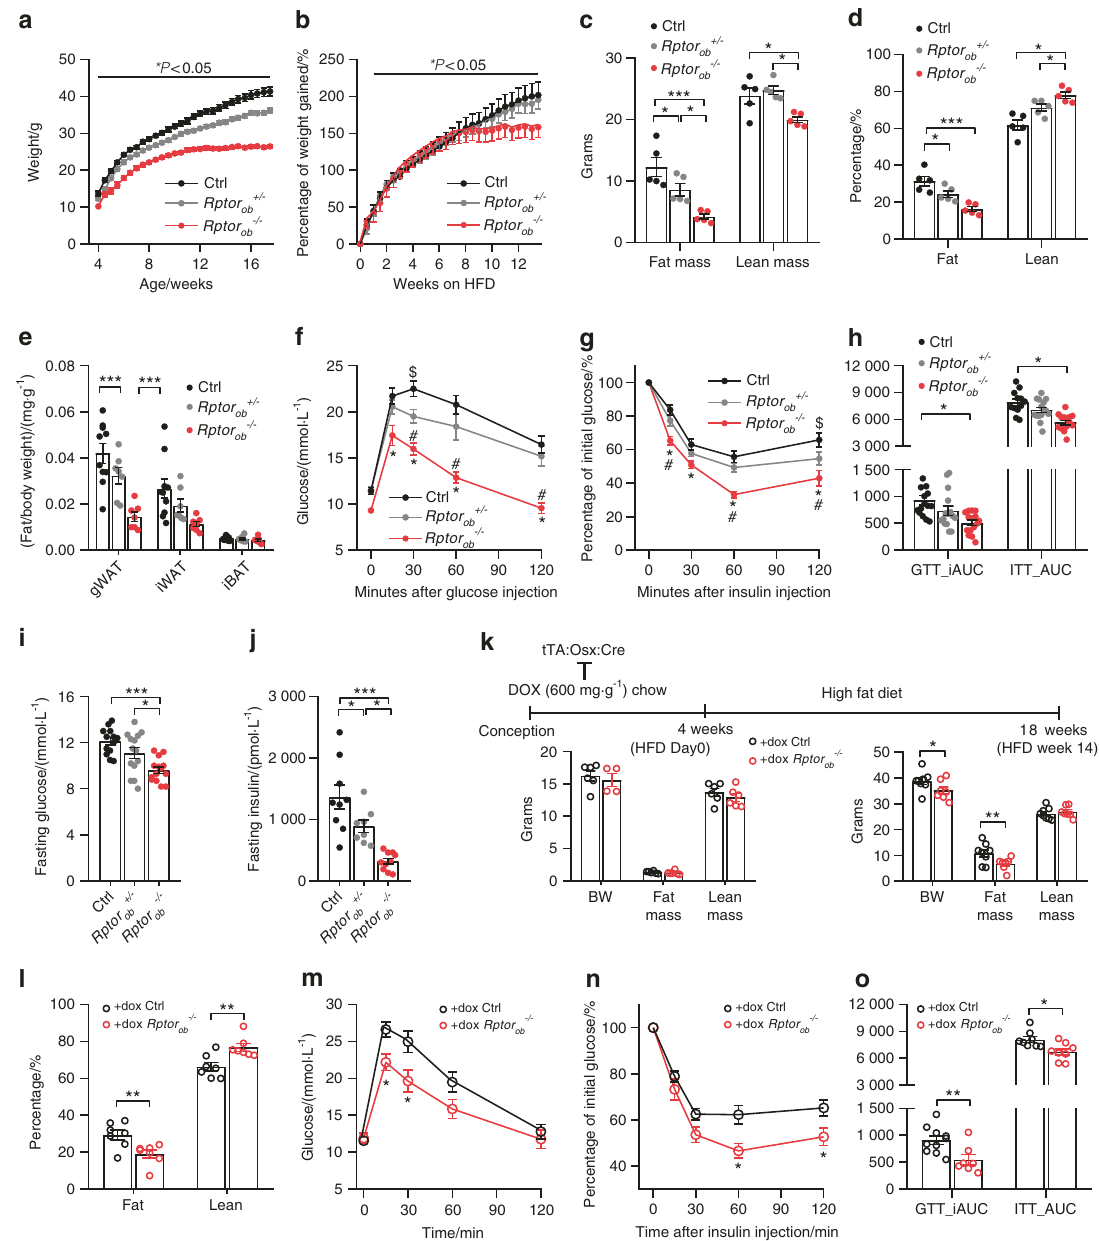
Fig. 4 Pre- and post-natal deletion of Rptor protects against high-fat diet-induced obesity and insulin resistance. a Temporal change in body weight ( n ≥ 15/genotype). b % of body weight gained in response to high-fat diet (HFD). c Body analysis by DXA scanning of total mass and d composition as percentage of body weight in 18-week-old HFD-fed mice ( n = 5/genotype). e Body weight adjusted fat depot ( n = 7 – 10/ genotype). f GTT blood glucose levels in 17-week-old mice. g ITT blood glucose levels in 16-week-old mice. h Incremental AUC analysis of GTT from f and AUC analysis of ITT from g ( n = 12 – 15/genotype). i Fasting blood glucose levels ( n = 13/genotype). j Fasting serum insulin levels ( n = 8 – 10/genotype). k Schematic showing use of doxycycline (DOX) administration to suppress the tTA:Osx:cre transgene until the pups are 4 weeks of age. DOX chow was replaced with a high-fat diet to induce obesity and insulin resistance (upper panel) . Body composition at 4 weeks (HFD day 0; n = 4 – 6/genotype) and 18 weeks (HFD week 14; n = 7 – 8/genotype) of age (lower panels) . l Body composition as percentage of total body weight n = 7 – 8/genotype). m GTT blood glucose levels in 17-week-old mice. n ITT blood glucose levels. o Incremental AUC analysis of GTT from m and AUC analysis of ITT from n ( n = 12 – 15/genotype). Data presented as mean ± SEM. a – e * P < 0.05, *** P < 0.001, One-way ANOVA with Tukey ’ s post hoc test. f , g * P < 0.05 between Rptor ob − / − and Ctrl, # P < 0.05 between Rptor ob − / − and Rptor ob + / − and $ P < 0.05 between Rptor ob + / − and Ctrl, two-way ANOVA with Tukey ’ s post hoc test. k – o * P < 0.05, ** P < 0.01, Student ’ s t